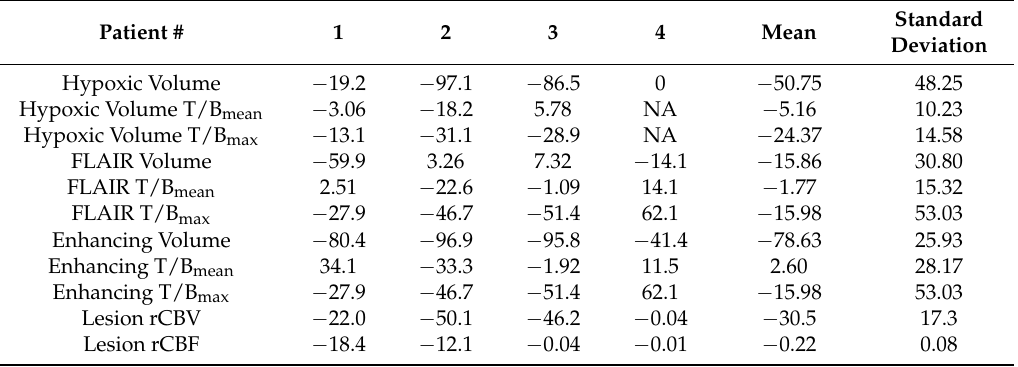
Table 2. Percent change of 18F-fluoromisonidazole (FMISO) metrics between imaging time